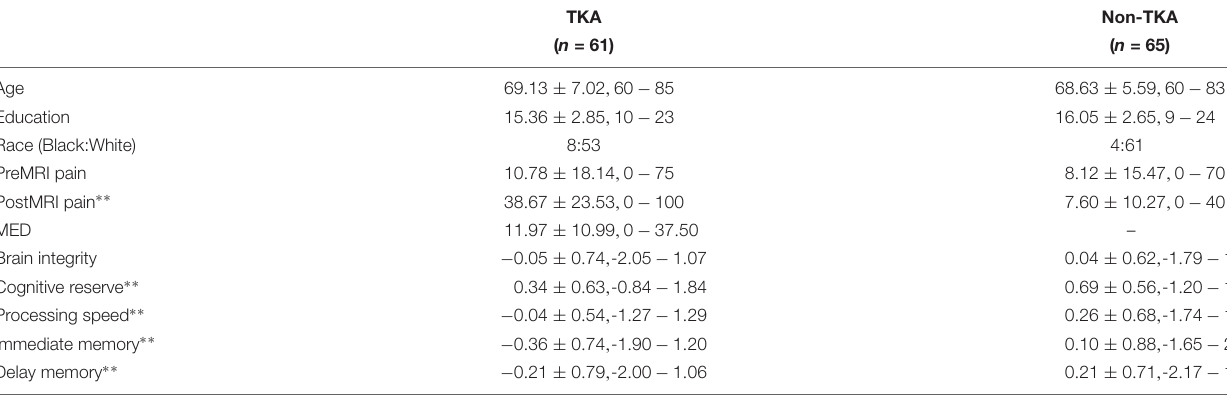
TABLE 1 | Demographic, brain, and cognitive scores by group.